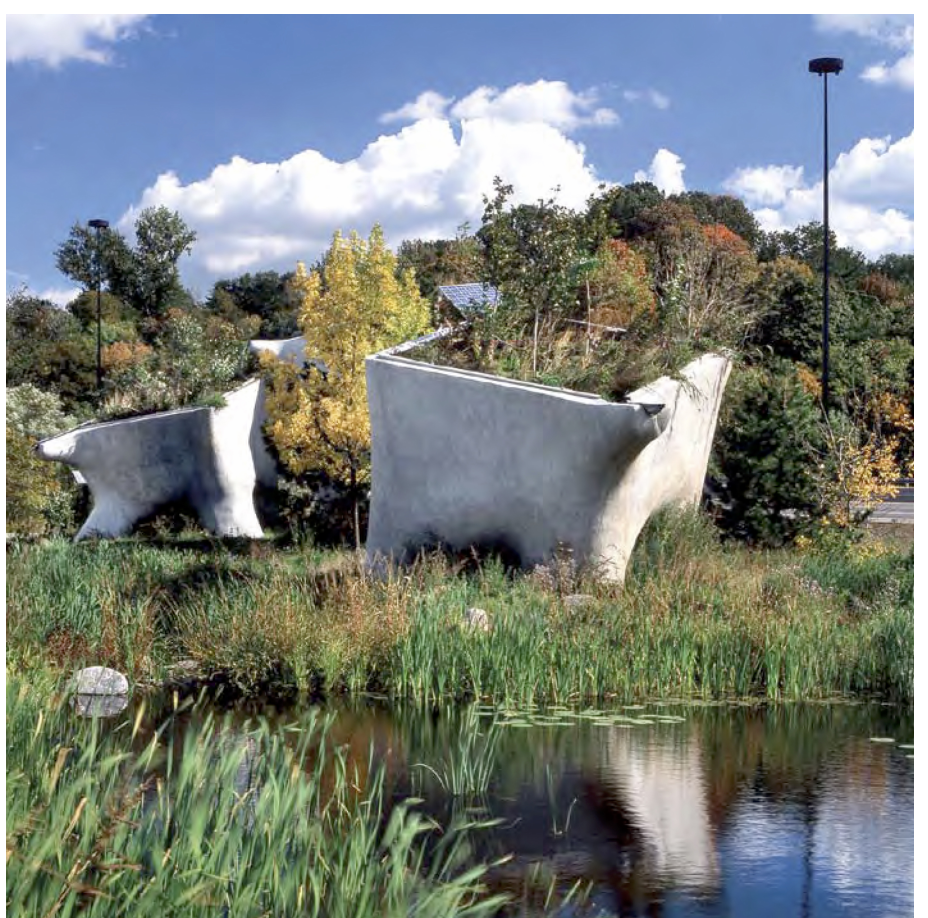
Figure 2: Noel Harding, The Elevated Wetlands , 1997-1999, six sculptures of ex- panded polystyrene foam, acrylic stucco coating, solar powered irrigation system, re- cycled plastic soil, native plants and water from the Don River. Image courtesy of Institute Without Boundaries. c (cid:13) Noel